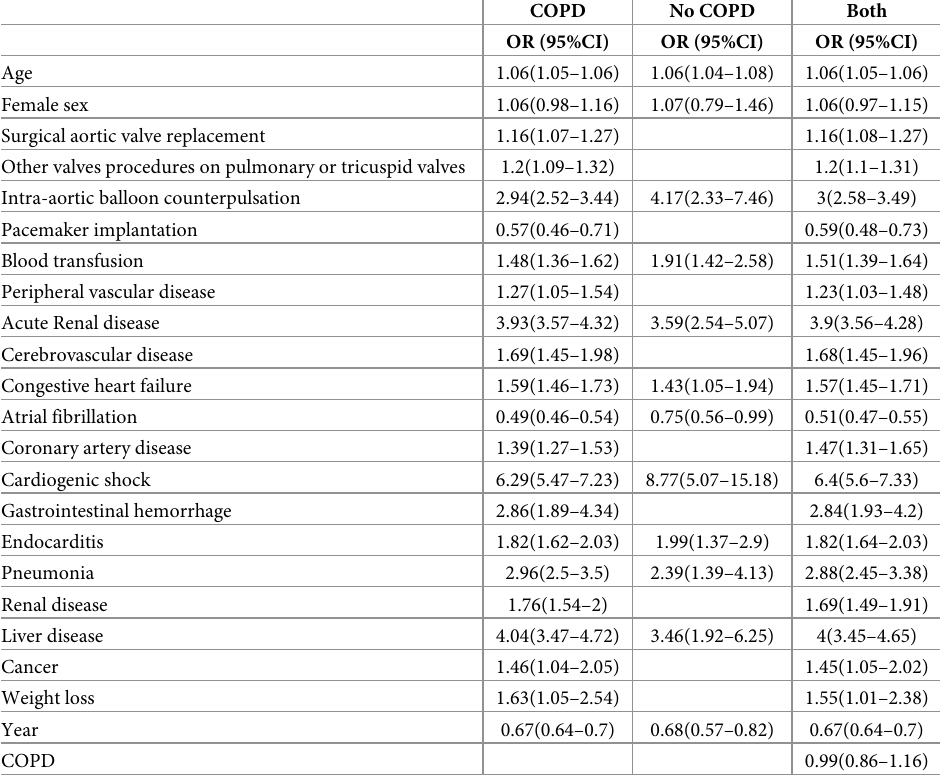
Table 6. Multivariable analysis of factors associated with IHM among COPD and non-COPD patients who under- went mechanical mitral valve replacement. COPD No COPD